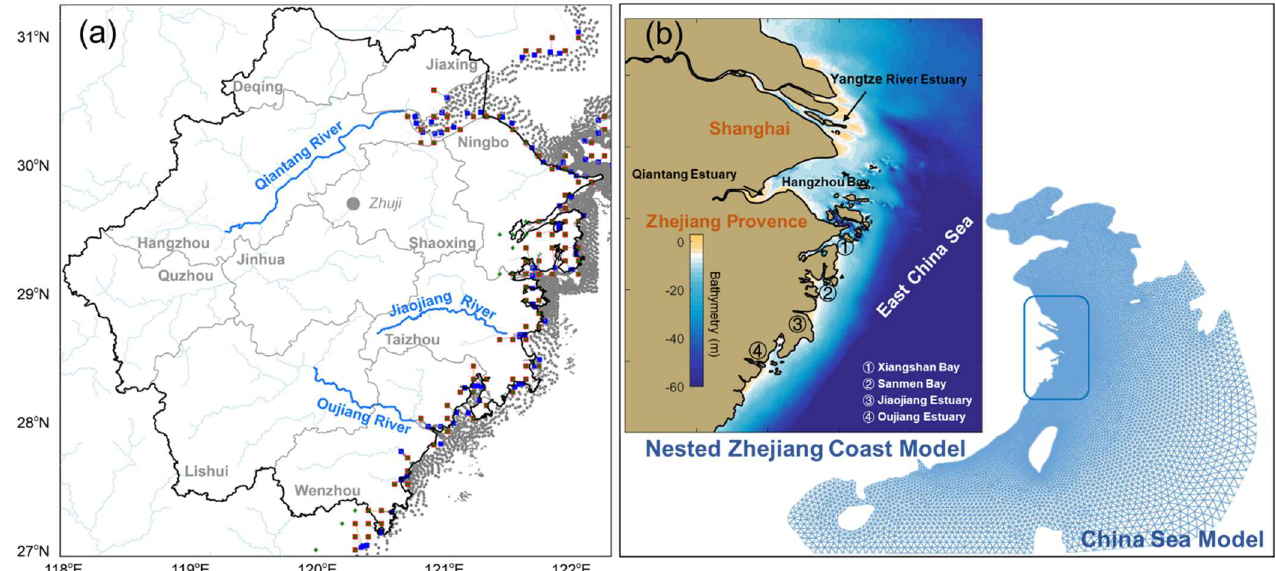
Figure 1. Illustration of the study area and surge model settings. ( a ) The Zhejiang Province (outlined by a thick black boundary) and its municipal level boundaries, outlined with light gray. Rivers with mean river discharge higher than 10 m 3 /s are illustrated with light blue, and the three major rivers are drawn with thick lines. The connections between coastal CaMa-Flood nodes (i.e., unit catchment in a red square) and surge model nodes (i.e., triangle apex, in a blue square) are shown with gray lines. The gray dots are the locations of nearshore simulation nodes from the surge model mesh, with 80% of the nodes not shown for better visualization. ( b ) Model domain for the Zhejiang Coast– China Sea nested model (surge model).